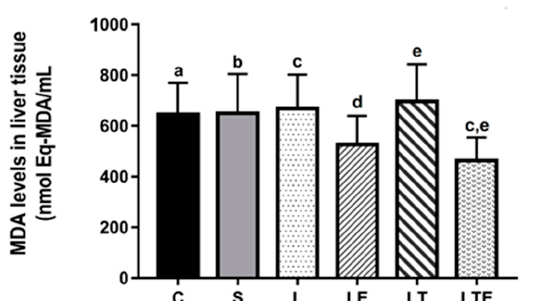
Figure 10. Analysis of MDA levelsin the liver.